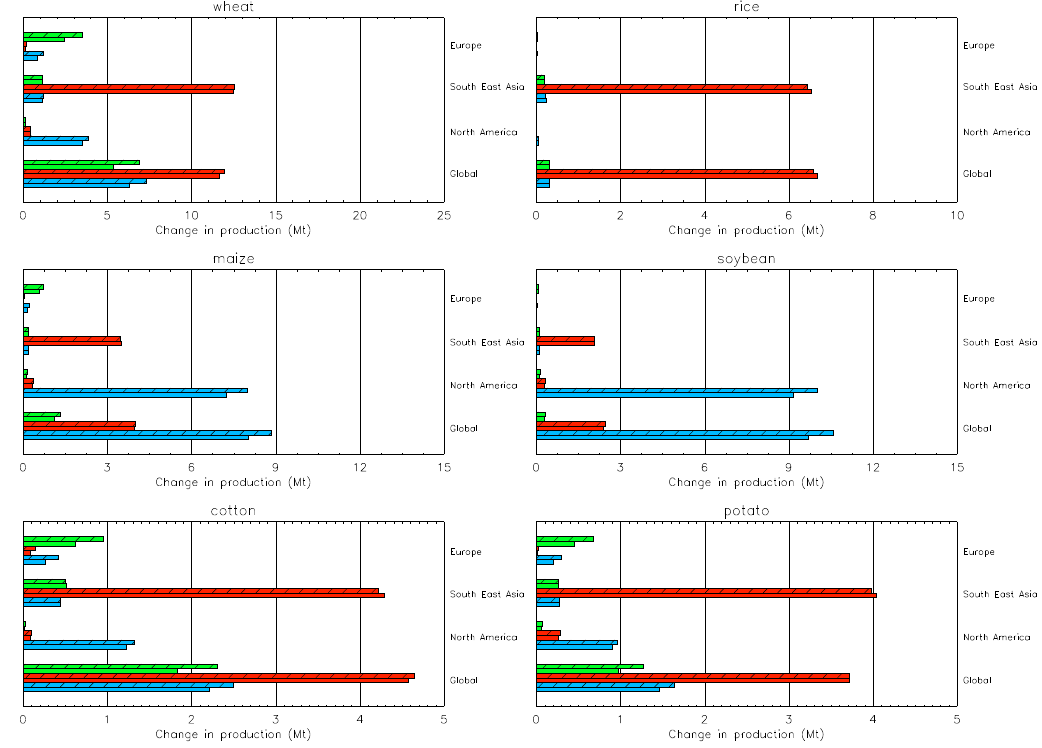
Fig. 13. Projected increase in crop production (in million metric tons(Mt)) for the 6 crops resulting from 100% regional cuts in anthropogenic NO x emissions. The y-axis shows the receptor regions, and coloured bars indicate the average impacts based on AOT40, Mx and W126 metrics from emission cuts applied in each region compared to the control model (Green=European emission cut, Red=SE Asia emission cut and Blue=N America emission cut). Solid colour bars show results based on the standard model metric and hatched bars show results based on the bias-corrected model metric (see main text for